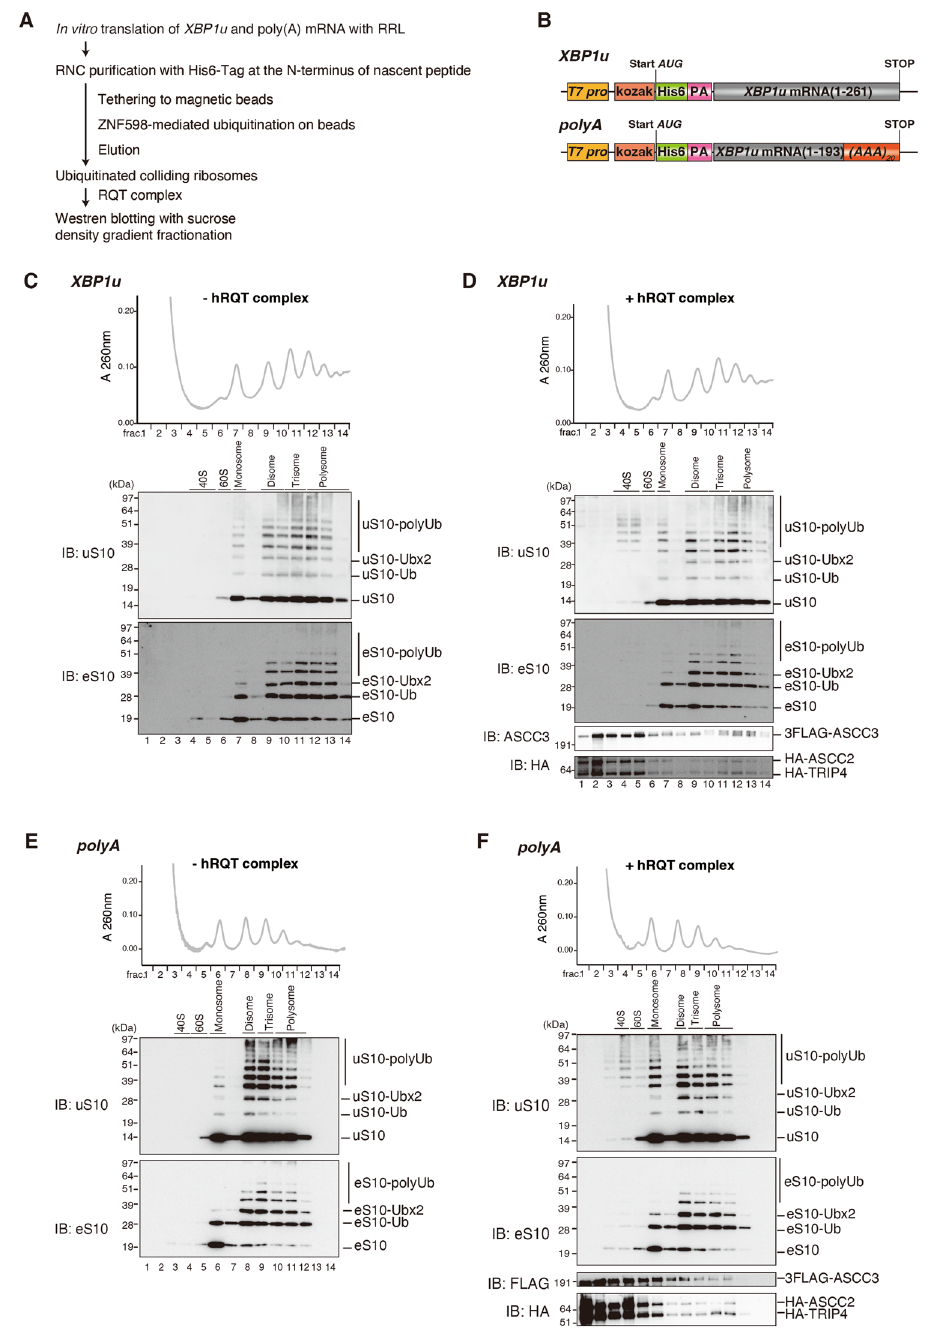
Fig.4|hRQT-mediatedsubunitdissociationofcollidedribosomes.A Schematic overview of the hRQT ribosome splitting assay. B Schematic representation of the XBP1u and poly(A) staller mRNAs. C – F Collided ribosomes derived from in vitro translation reactions of XBP1u ( C , D ) or poly(A) ( E , F ) staller mRNAs were isolated andubiquitinatedbyZNF598.Thepuri fi edubiquitinatedRNCswereincubatedwith